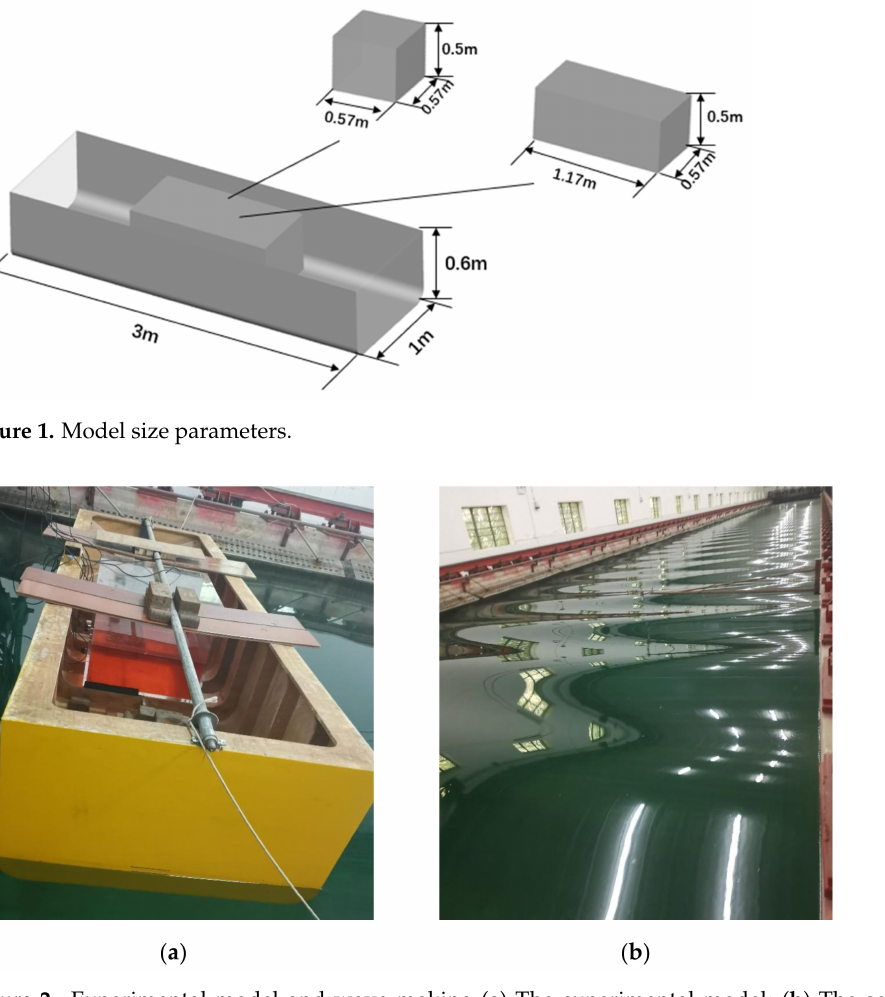
Figure 2. Experimental model and wave making ( a ) The experimental model; ( b ) The scene of making waves.